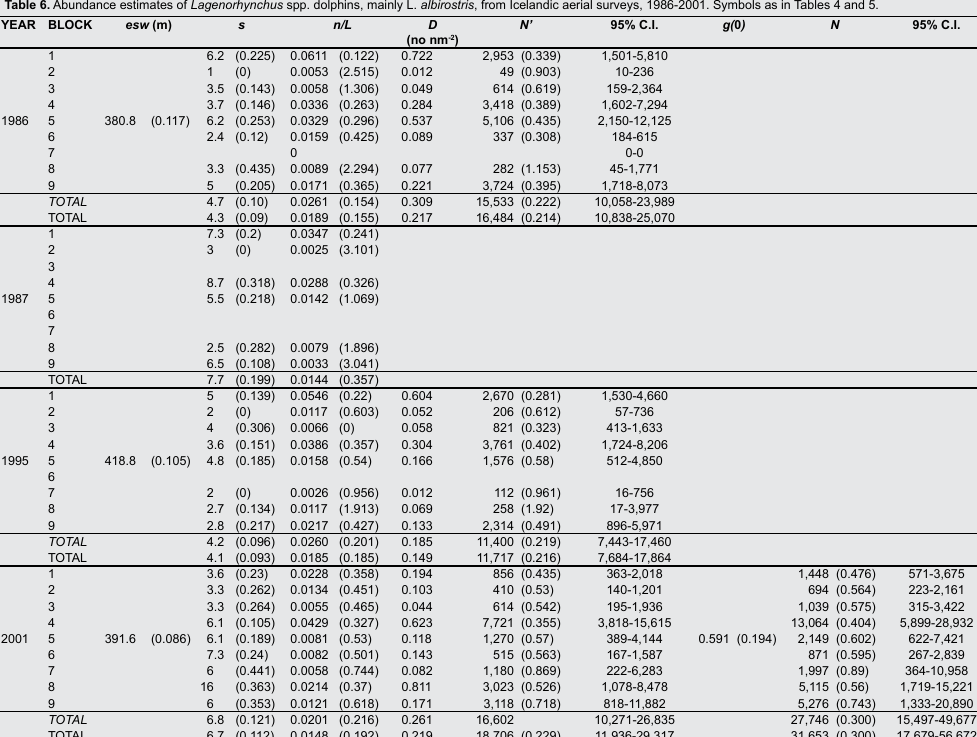
Table 6. Abundance estimates of Lagenorhynchus spp. dolphins, mainly L. albirostris , from Icelandic aerial surveys, 1986-2001. Symbols as in Tables 4 and 5. YEAR